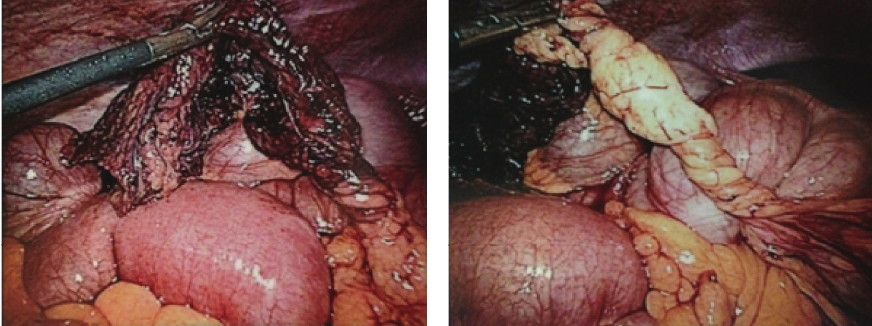
Figure 2: Intraoperative situs demonstrating omental torsion and